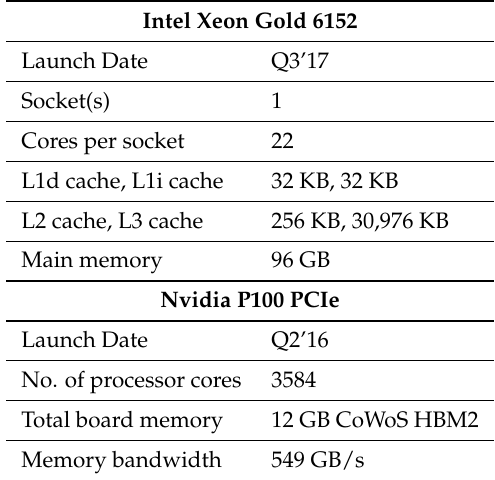
Table 2. HCLServer2: Specifications of the Intel Skylake multicore CPU and Nvidia P100